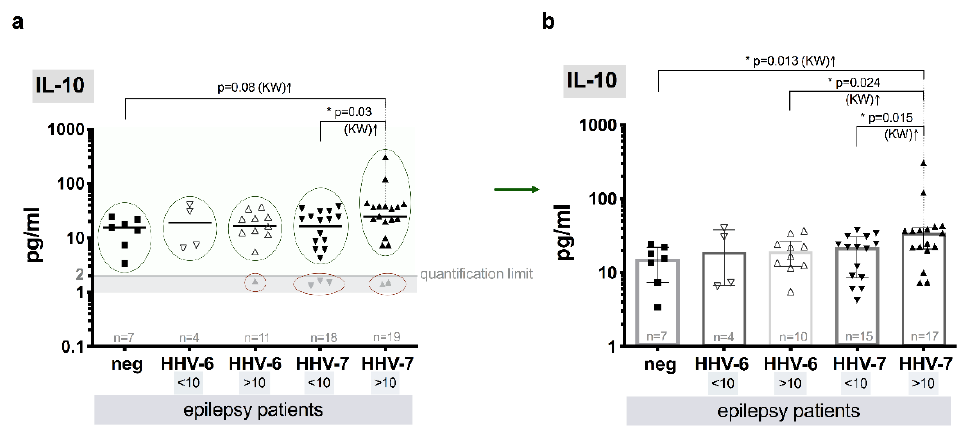
Figure 5. Comparative blood plasma level of IL-10 in epilepsy patients: ( a ) scatter plots with medians of HHV-6 and HHV-7 negative (neg) and HHV-6 and HHV-7 positive viral load ( < 10 and > 10 copies / 10 6 cells), gray symbols (marked with red ovals) show values below quantification limit (QL); ( b ) scatter plots with bars (medians with IQR) that represent values above QL (marked with green ovals in a) of HHV-6 and HHV-7 negative (neg) and HHV-6 and HHV-7 positive viral load ( < 10 and > 10 copies / 10 6 cells), values below QL are excluded; asterisks and respective p represent significance level of di ff erences between the groups (KW—Kruskal–Wallis